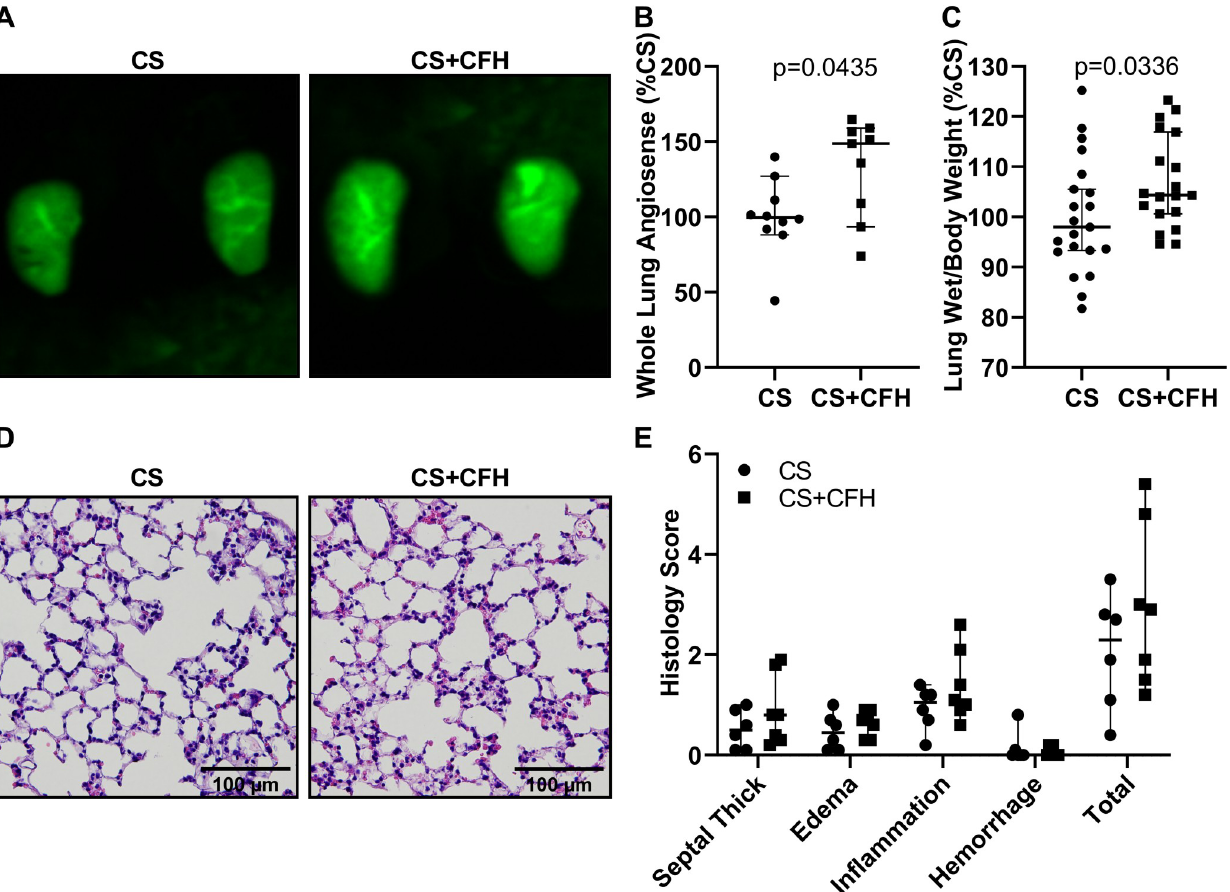
Fig 4. CFH increases lung edema formation in murine sepsis. Lung microvascular permeability was measured by accumulation of fluorescent AngioSense in mouse lungs 24 hours after injection of sepsis. (A) Excised lungs were imaged using a high sensitivity camera. (B) Fluorescence intensity was quantified and was higher in CS+CFH versus CS alone (n = 9–10, p = 0.0435). (C) To measure lung fluid accumulation, we calculated lung wet weight to mouse body weight, expressed as a percent of CS treatment, and found that CS+CFH increases lung weight versus CS alone (n = 19–21, p = 0.0336). (D-E) Lung histology showed slightly increased septal thickening, edema, and inflammation in CS+CFH versus CS alone but was not statistically different (n =